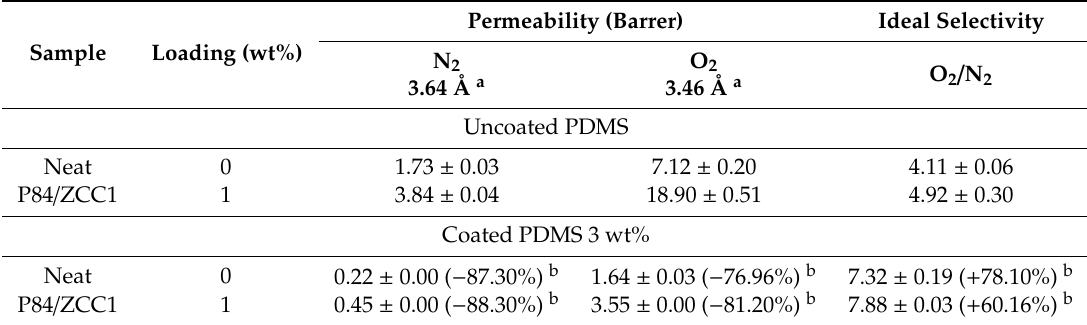
Table 1. Single gas performance of mixed matrix membranes (MMMs).